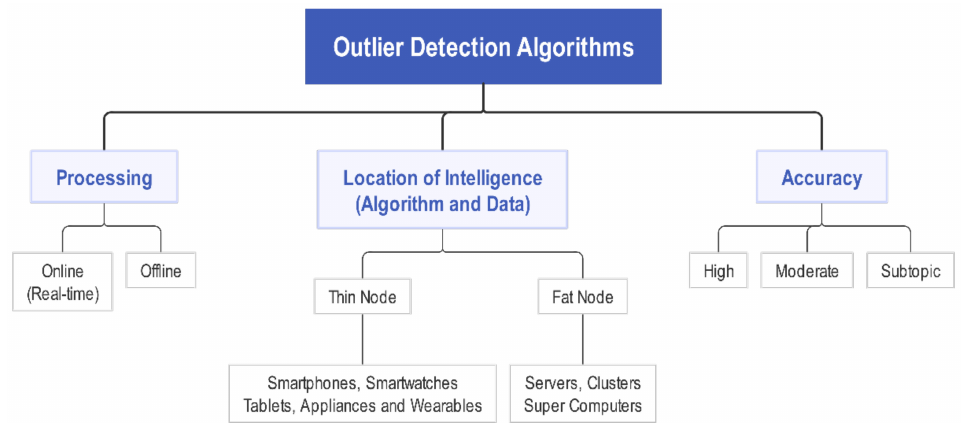
Figure 5. Classification of future outlier detection algorithm that adopt machine learning for IoT